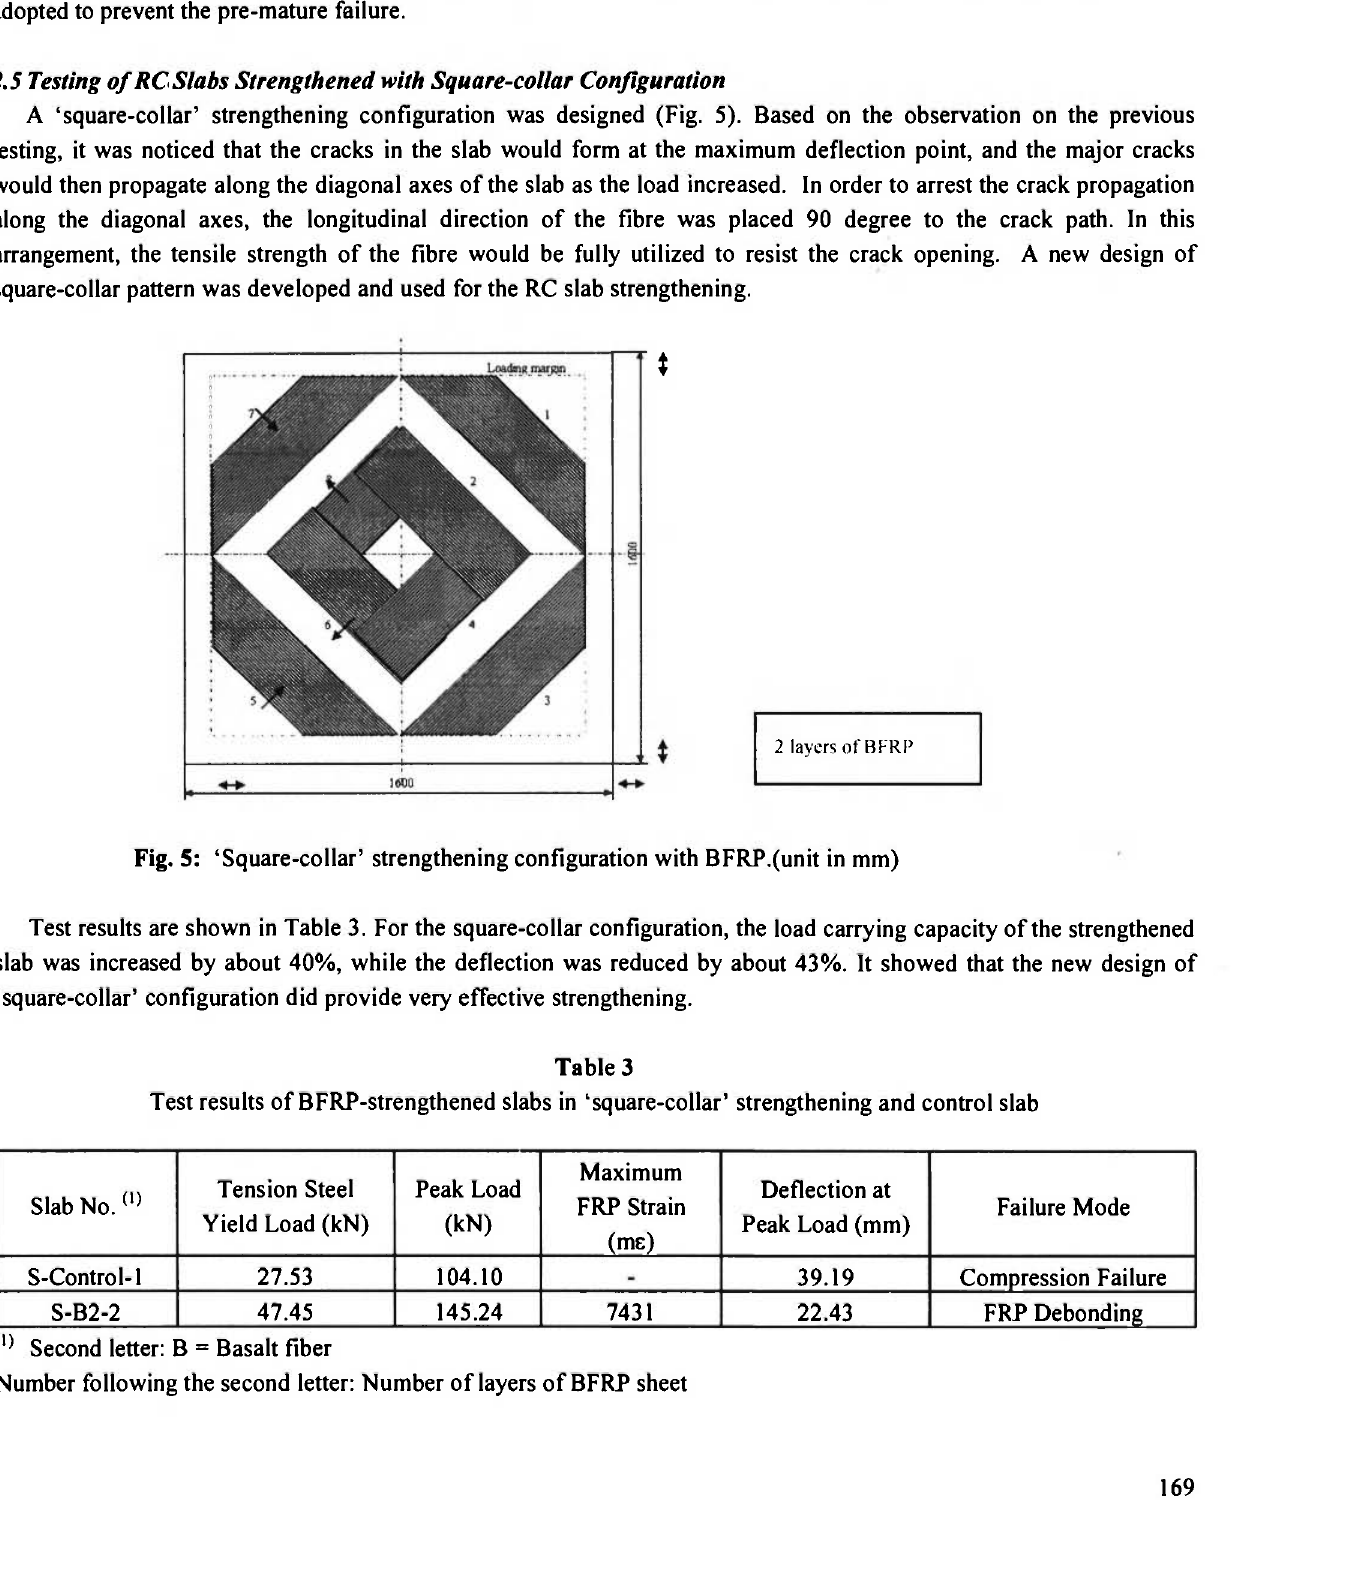
Test results of BFRP-strengthened slabs in 'square-collar' strengthening and control slab